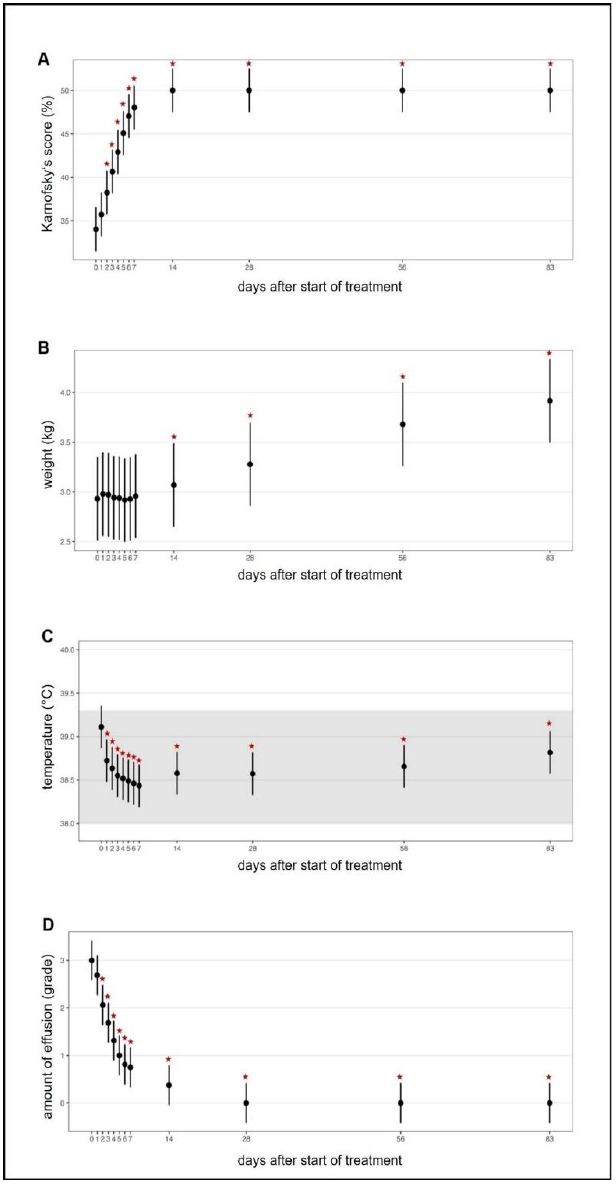
Figure 3 Figure 3. Timeline visualizing improvement of clinical parameters throughout the study course. Figures show average predictive values and 95% confidence intervals of each parameter. Grey shading marks the reference ranges of the parameters. Red asterisks mark significant difference ( p ≤ 0.05) of the parameters on different days of treatment when compared to day 0 (before treatment) measured by a linear mixed-effects model (for temperature) and by robust linear mixed-effects models. ( A ) Karnofsky’s score modified for cats. ( B ) Body weight. ( C ) Body temperature. ( D ) Amount of effusion subjectively evaluated during abdominal/thoracic ultrasound and paracentesis (grades 0 (no fluid) to 4 (massive